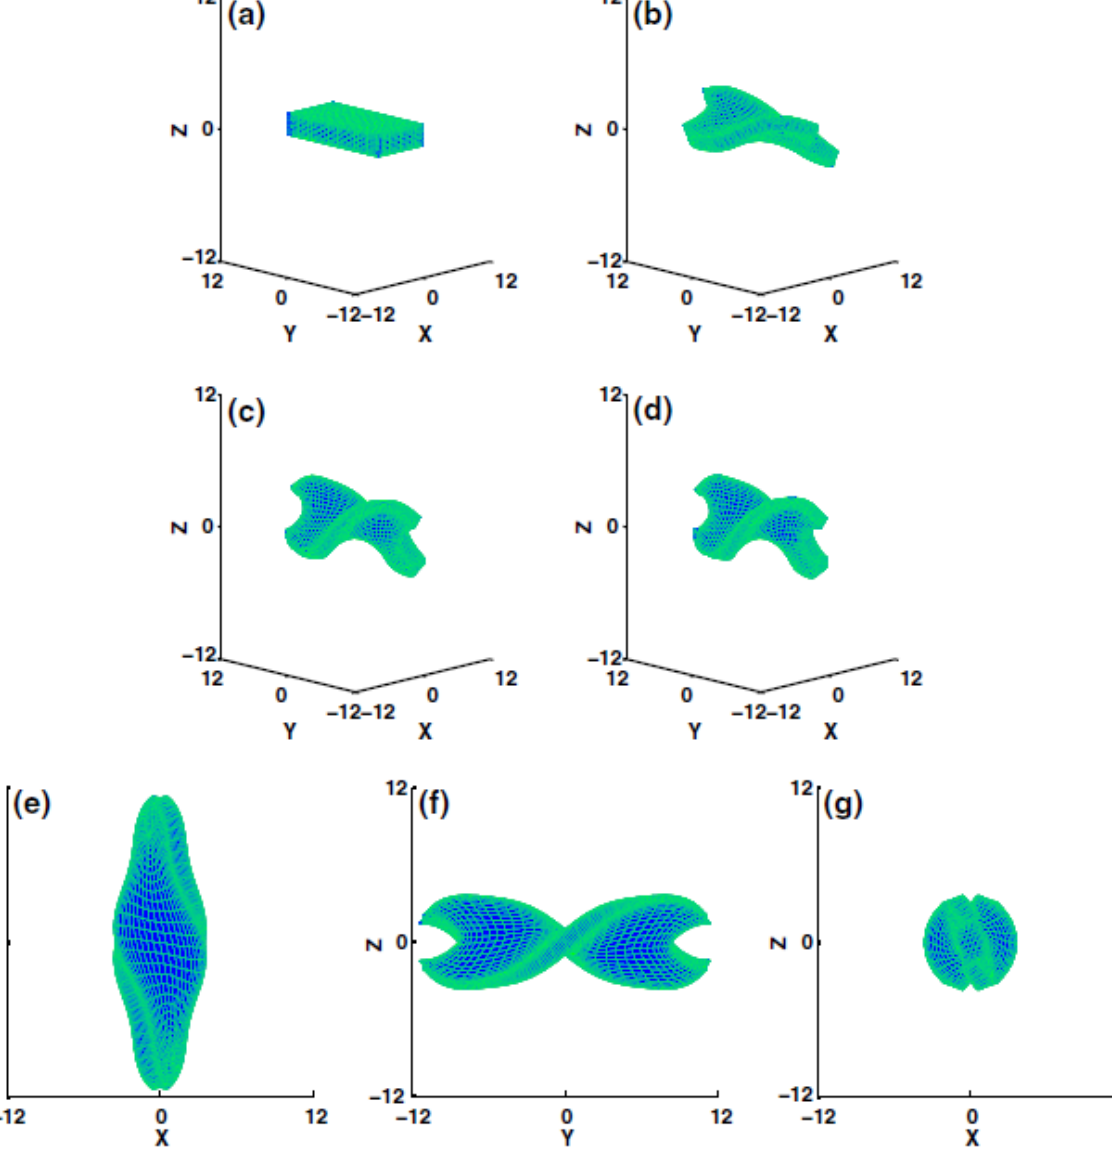
Figure 15. Evolution of the LCE sample as a result of inhomogeneous temperature distribution. ( a ) the LCE is in its initial state ( b , c ) both show two transitional states, and ( d ) demonstrates the sample after reaching steady state condition. ( e – g ) illustrate the LCE sample of ( d ) from three different points of view [112]. (Reprinted with permission from [112]).